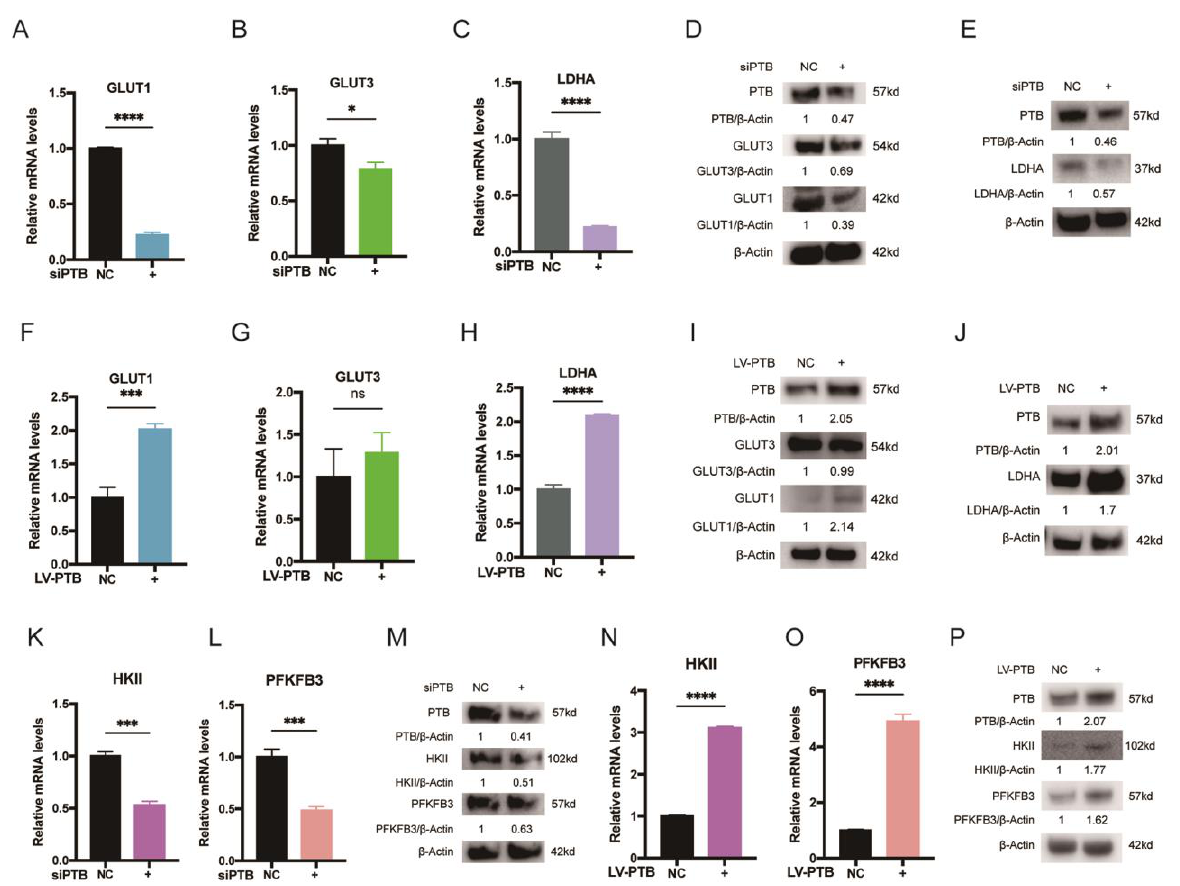
Figure 3. PTB promotes glycolysis enzymes in KFb. The mRNA ( A – C ) and protein ( D , E ) levels of GLUT1, GLUT3, and LDHA in the KFb transfected with siPTB were determined. The mRNA ( F – H ) and protein ( I , J ) levels of GLUT1, GLUT3, and LDHA in the NFb transfected with the PTB lentivirus were determined. The mRNA levels of HKII ( K ) and PFKFB3 ( L ) in KFb transfected with siPTB were investigated by qRT-PCR. ( M ) Their protein levels were determined by Western blotting. The mRNA level of HKII ( N ) and PFKFB3 ( O ) in NFb transfected with the PTB lentivirus were investigated by qRT-PCR. ( P ) Their protein levels were determined by Western blotting ( n = 3). Data are presented as the mean ± S.D. * p < 0.05, *** p < 0.001, **** p < 0.0001.